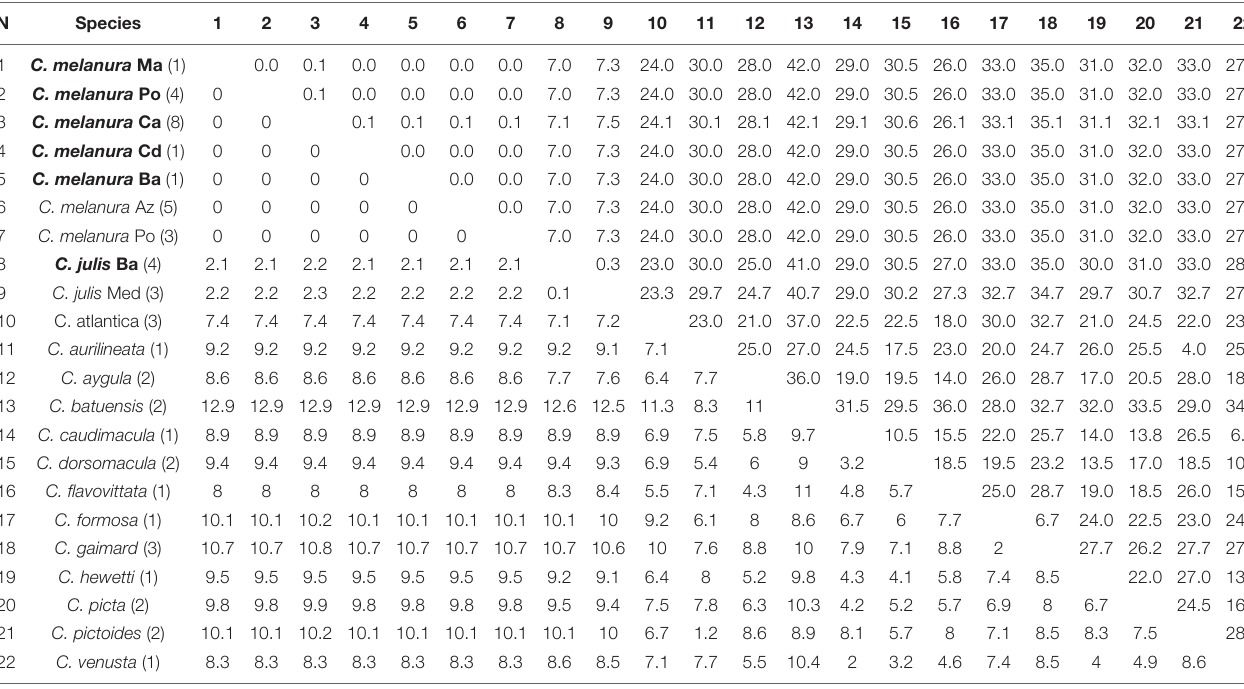
TABLE 4 | Mean genetic distances (%) and numbers of base differences for 12s rRNA from Coris species below and above the diagonal,